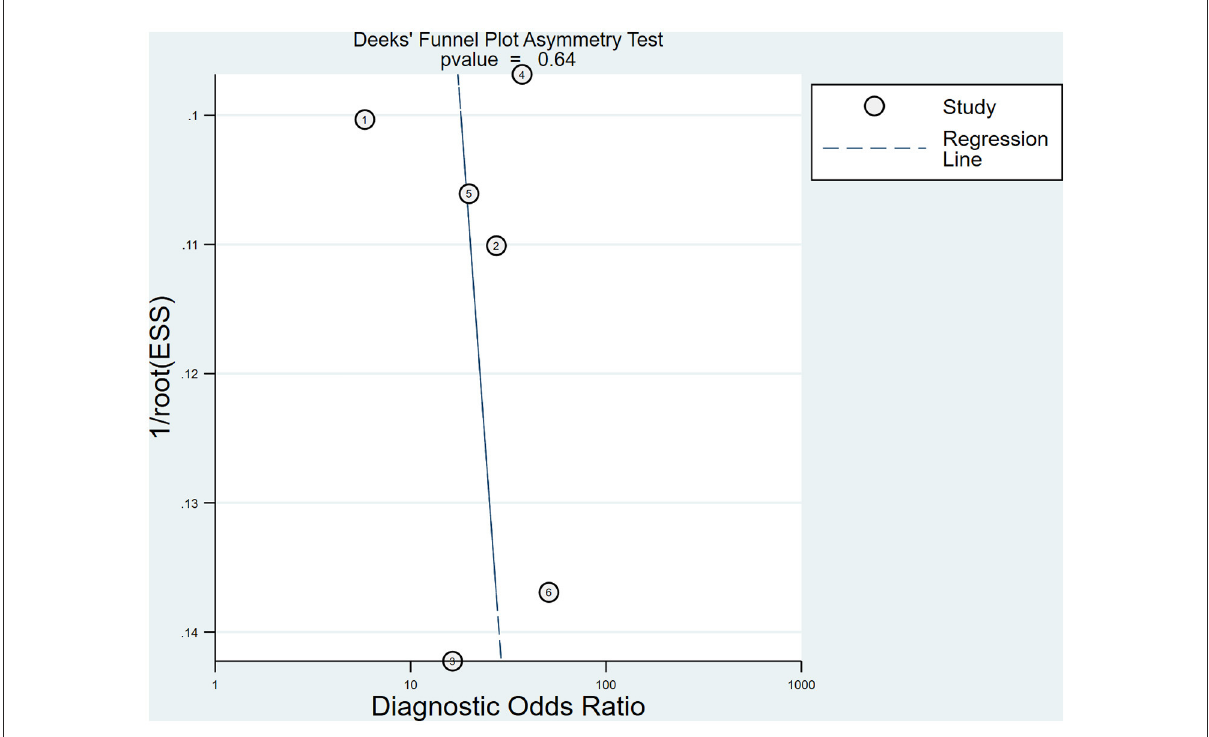
FIGURE6 Deeks’ funnel plot used to assess publication